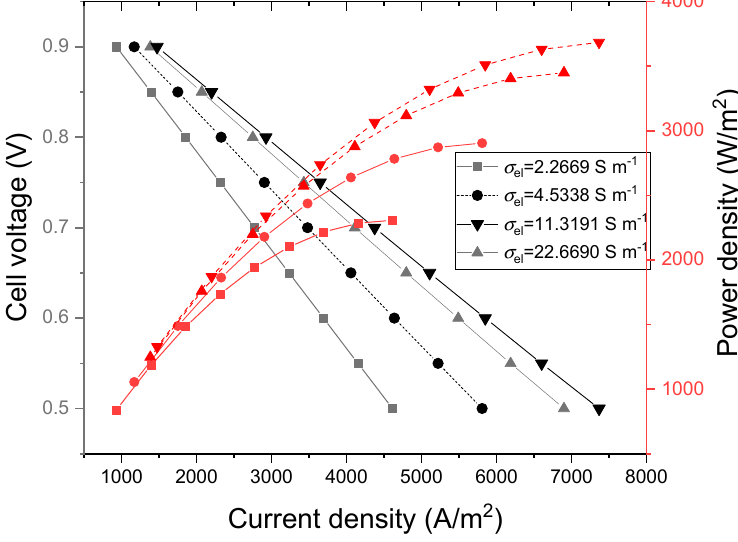
Figure 6. Comparison among cases with different ionic conductivities.